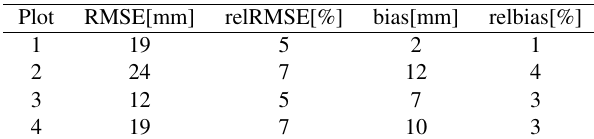
Table 1. Stem diameter (DBH) estimations for linked trees on four field plots.